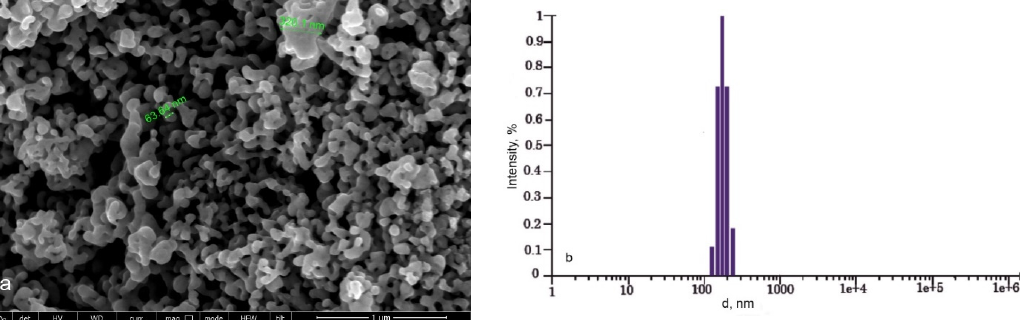
Figure 4. Morphology of synthesized LiFePO 4 /C: ( a ) High Resolution Scanning Electron Microscopy HRSEM image; ( b ) particle size distribution.